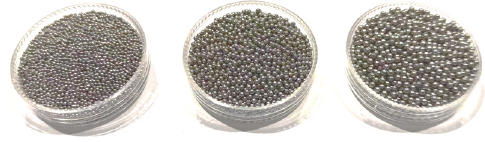
Figure 5. Different particle size samples.